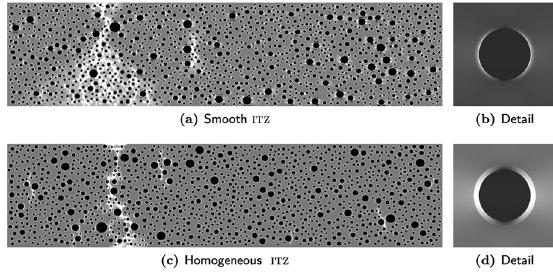
Figure 6. Simulation of influence of properties of interfacial transition zone on crack propagation in concrete using extended finite elements; assuming a smooth transition of properties in the ITZ (top) and a uniform properties in the ITZ (bottom)